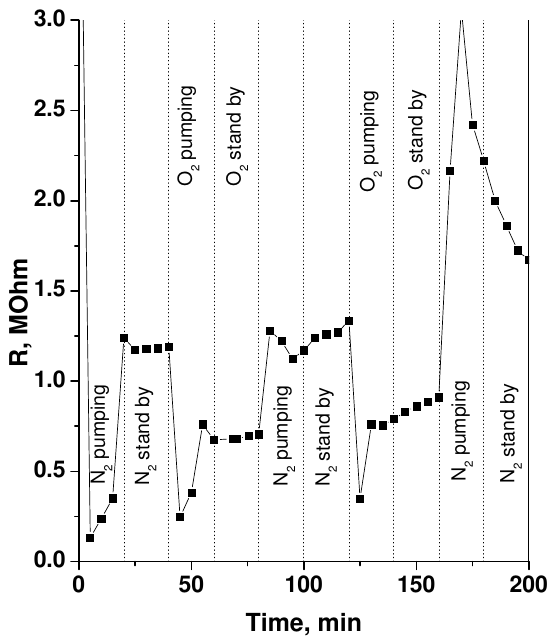
Fig. 3 Dependence of the resistance of pure YSZ in an atmosphere of differing oxygen content at 1060 K, measured during the first day of the experiment. The sample is obtained by spray pyrolysis. The data show a transition from low (1st and 2nd cycle) to high resistance under nitrogen atmosphere (3rd cycle).